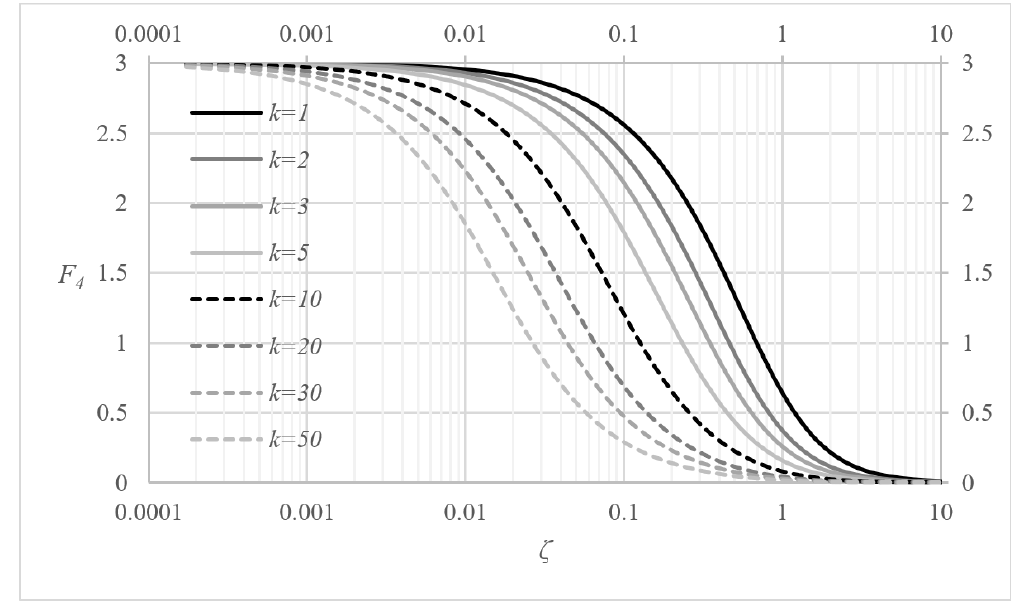
F factor with respect to  . Figure 5. Chart giving the Figure 5. Chart giving the F 4 factor with respect to ζ 4